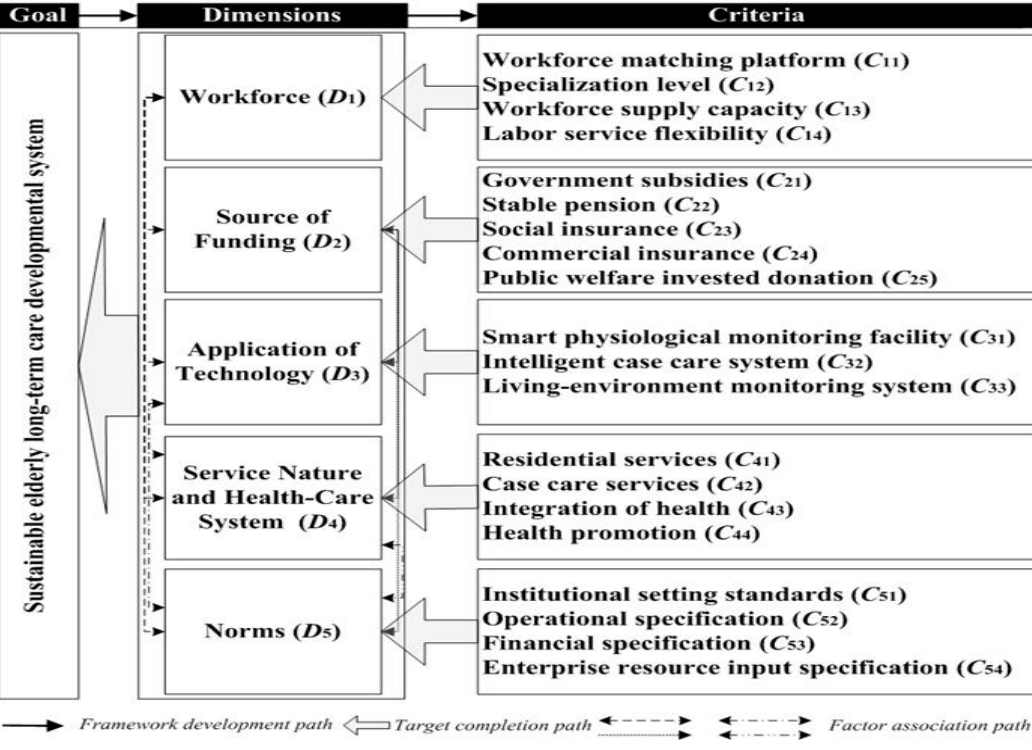
Figure 1. Evaluation framework for sustainable ageing health care in communities.